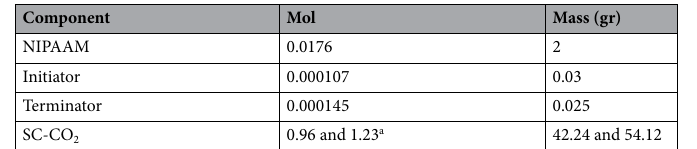
Table 1. The amount of raw materials used for producing difunchtionalized polymer chains. a These quantities were used for two different pressures level.